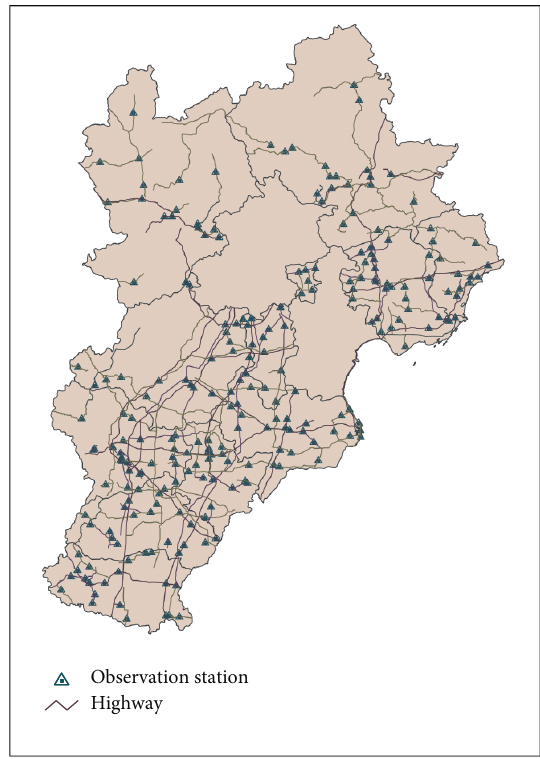
Figure 1: The layout of the observation stations in the highway Table 1: The main attribute information of the observation station.